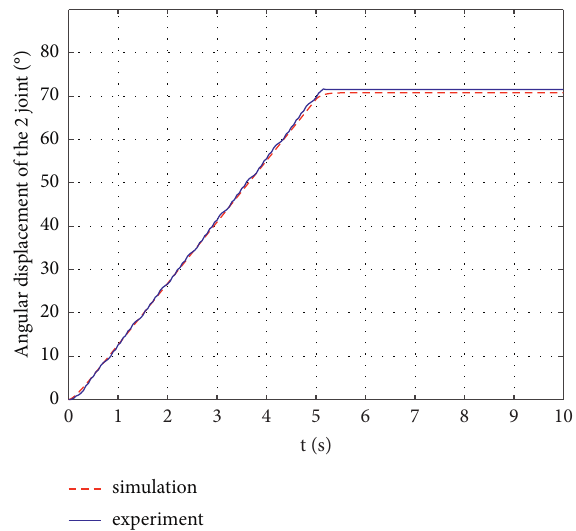
Figure 15: Comparison of flexible joint angular displacement.